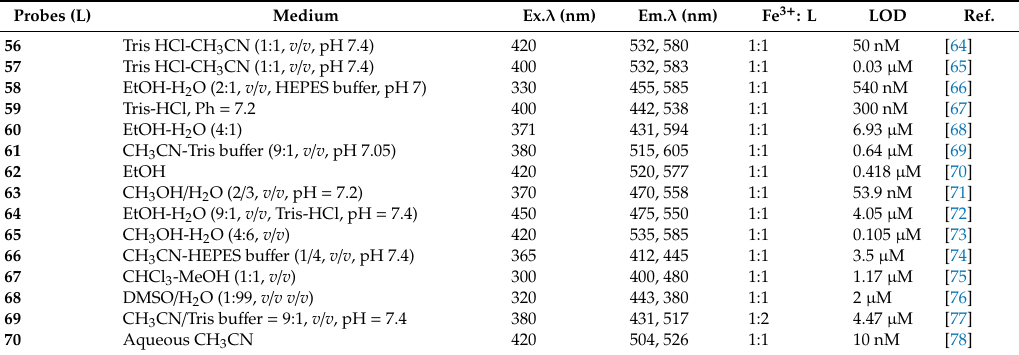
Table 3. Physiochemical properties of some iron(III) selective ratiometric fluorescent probes. Probes (L) Medium Ex. λ